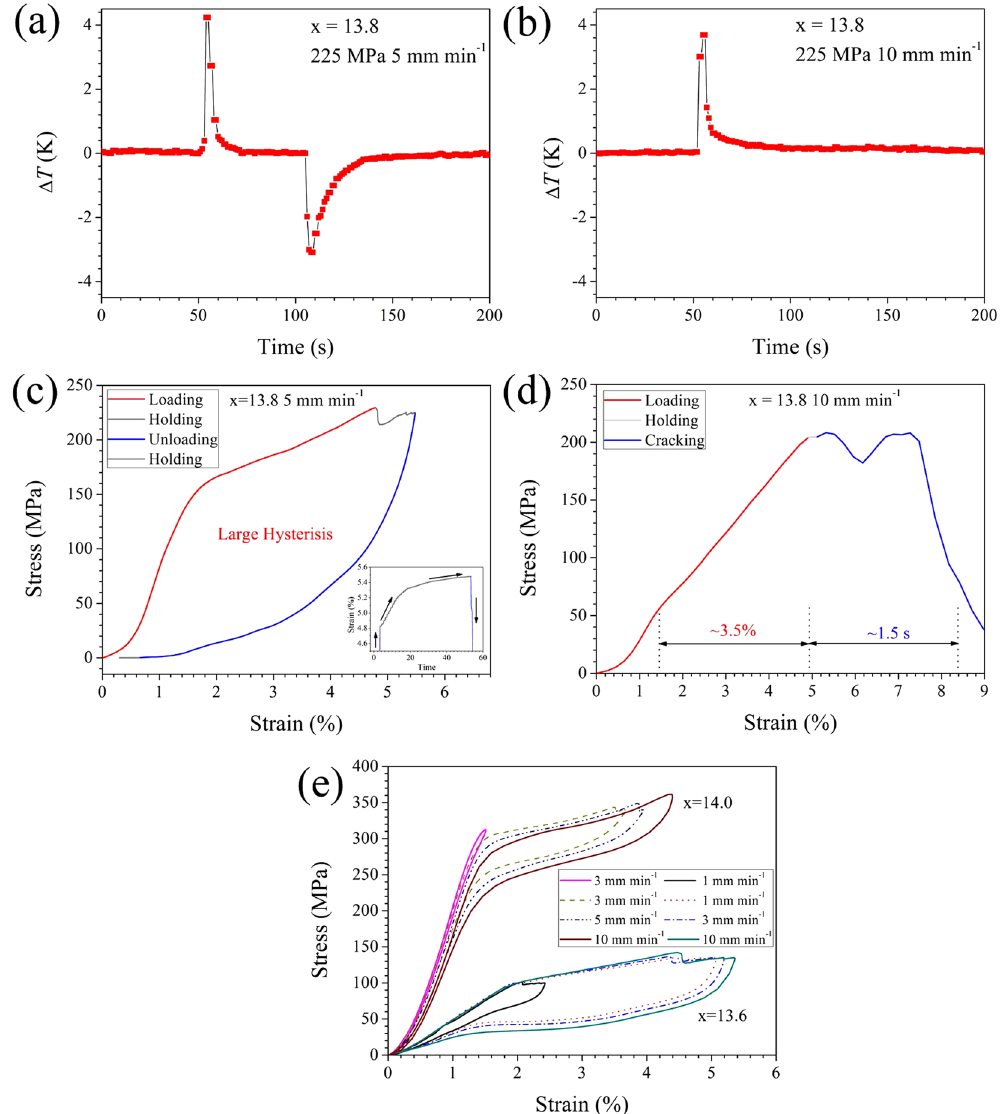
Figure 4. Typical quasi-adiabatic temperature–time profiles and stress–strain responses for large-stress- hysteresis Ni 45 Mn 50 − x In x Co 5 samples (x = 13.8): ( a , c ) 5 mm min − 1 and ( b , d ) 10 mm min − 1 . The insets in ( c ) show the corresponding strain–time responses during the loading, holding and unloading processes. The evolution of the stress-strain responses for the x = 13.6 and x = 14.0 samples at room temperature is shown in ( e ), wherer the applied conditions correspond to those in Fig. 3(a) and (b),